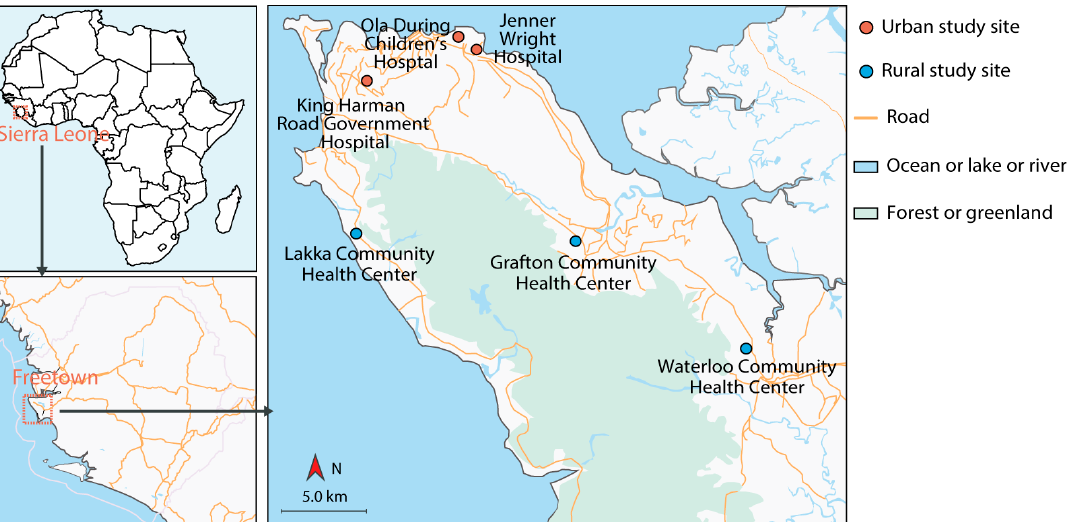
Figure 1. Geographic location of the study sites. Health care facilities in WAU included: Ola During Children’s Hospital (ODCH) (8 ◦ 29 (cid:48) 25 (cid:48)(cid:48) E, 13 ◦ 13 (cid:48) 7 (cid:48)(cid:48) S), King Harmann Road Government Hospital (8 ◦ 28 (cid:48) 27 (cid:48)(cid:48) E, 13 ◦ 14 (cid:48) 52 (cid:48)(cid:48) S), and Jenner Wright Hospital (8 ◦ 29 (cid:48) 7 (cid:48)(cid:48) E, 13 ◦ 12 (cid:48) 43 (cid:48)(cid:48) S). Health care facilities in WAR included: Waterloo Community Health Center (8 ◦ 20 (cid:48) 08 (cid:48)(cid:48) E, 13 ◦ 4 (cid:48) 24 (cid:48)(cid:48) S), Grafton Community Health Center (8 ◦ 23 (cid:48) 34 (cid:48)(cid:48) E, 13 ◦ 9 (cid:48) 23 (cid:48)(cid:48) S), and Lakka Community Health Center (8 ◦ 23 (cid:48) 49 (cid:48)(cid:48) E, 13 ◦ 15 (cid:48) 50 (cid:48)(cid:48)